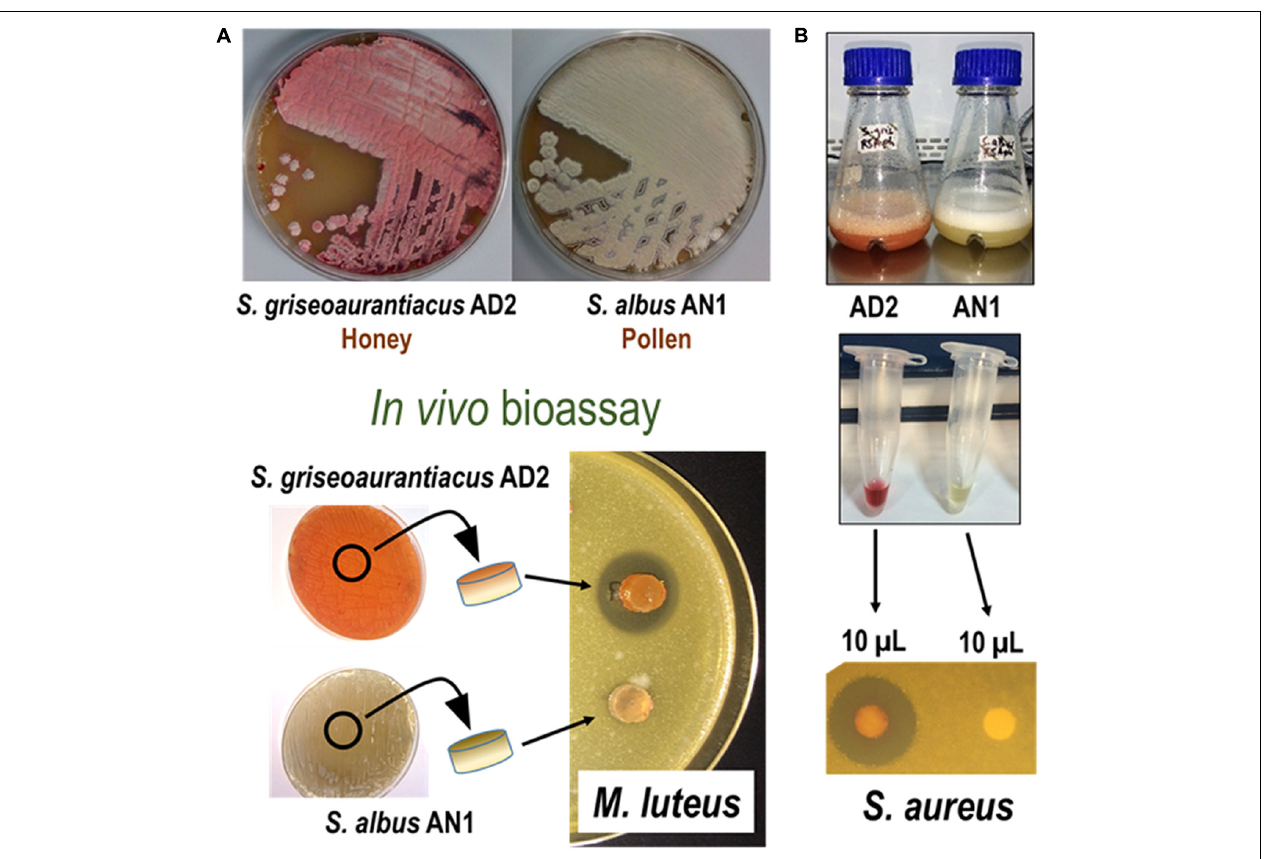
FIGURE 1 | Phenotypic and antibiotic activity characterization of Streptomyces albus AN1 and Streptomyces griseoaurantiacus AD2. The figure shows two bioassays in which live cells (A) and cell extracts (B) derived from both strains are tested against Micrococcus luteus or Staphylococcus aureus . Same results were observed using Bacillus cereus , Enterococus faecalis, and Streptomyces coelicolor